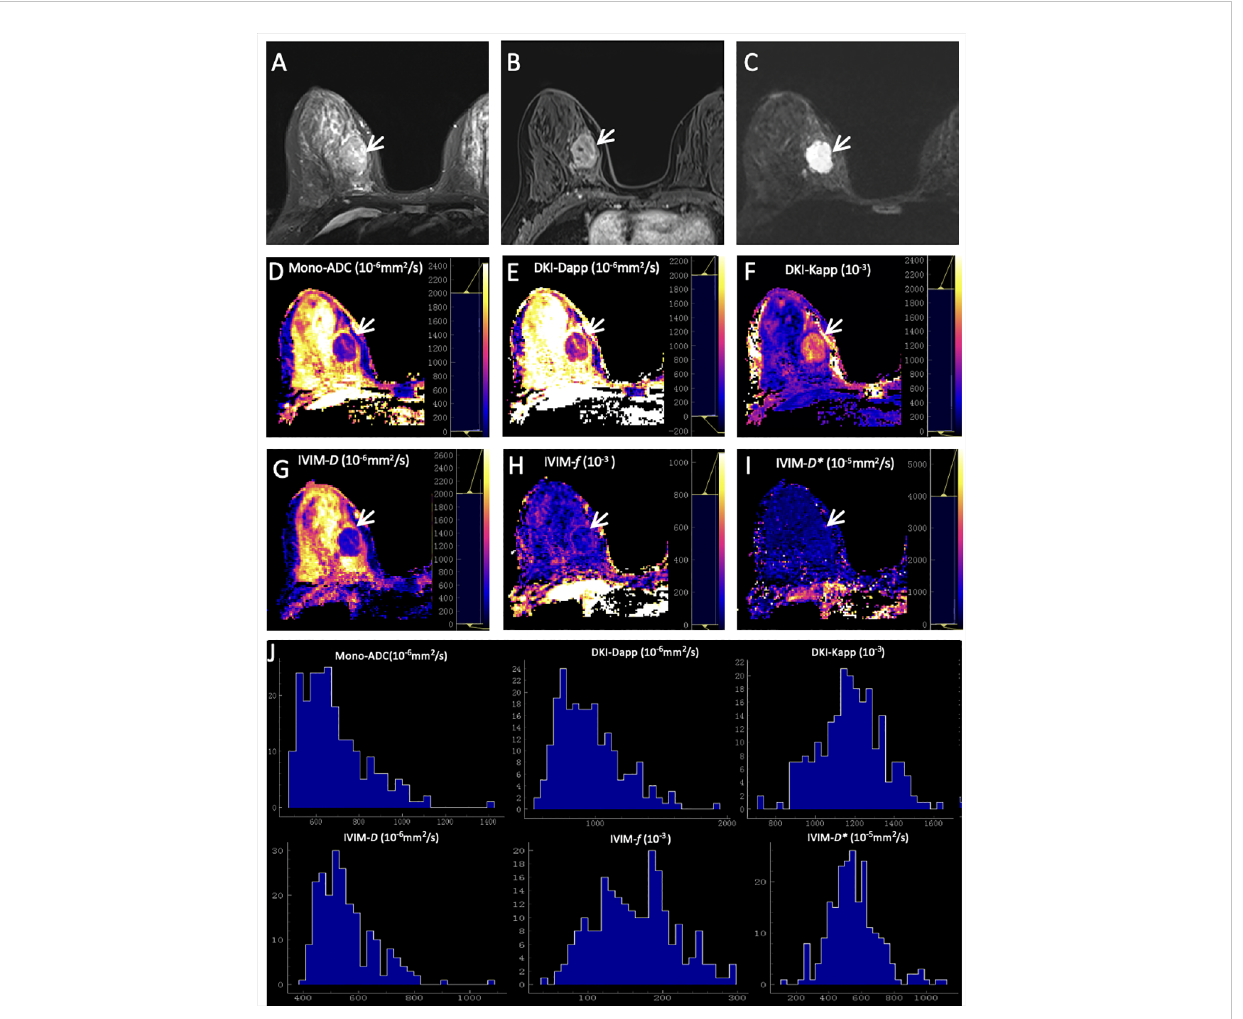
FIGURE 2 Representative images of a grade 2 invasive ductal carcinoma in the right breast of a 42-year-old woman. This tumor was with positive expression of estrogen receptor (95%) and progesterone receptor (20%), high Ki-67 (40%), and negative HER2 expression. (A) T2WI. (B) This mass is oval and with obvious enhancement (arrow) on axial DCE-MRI. (C) This mass shows oval shape, smooth margin, and homogeneous signal on DWI (b-value = 1000 mm 2 /s) (arrow). ADC (D) , Dapp (E) , Kapp (F) , D (G) , f (H) , and D* (I) maps and histograms of each map (J) are as